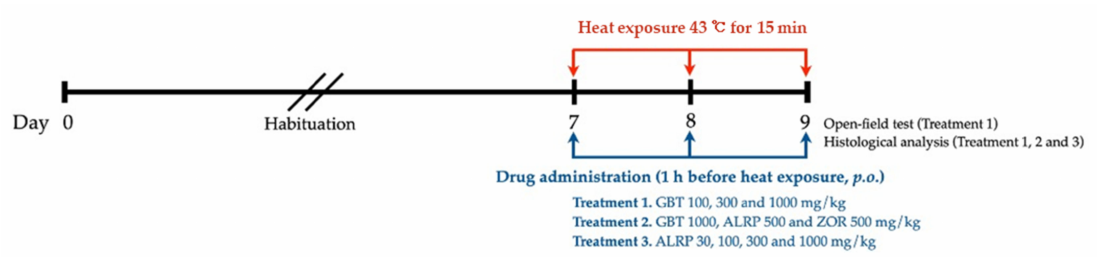
Figure 1. Experimental